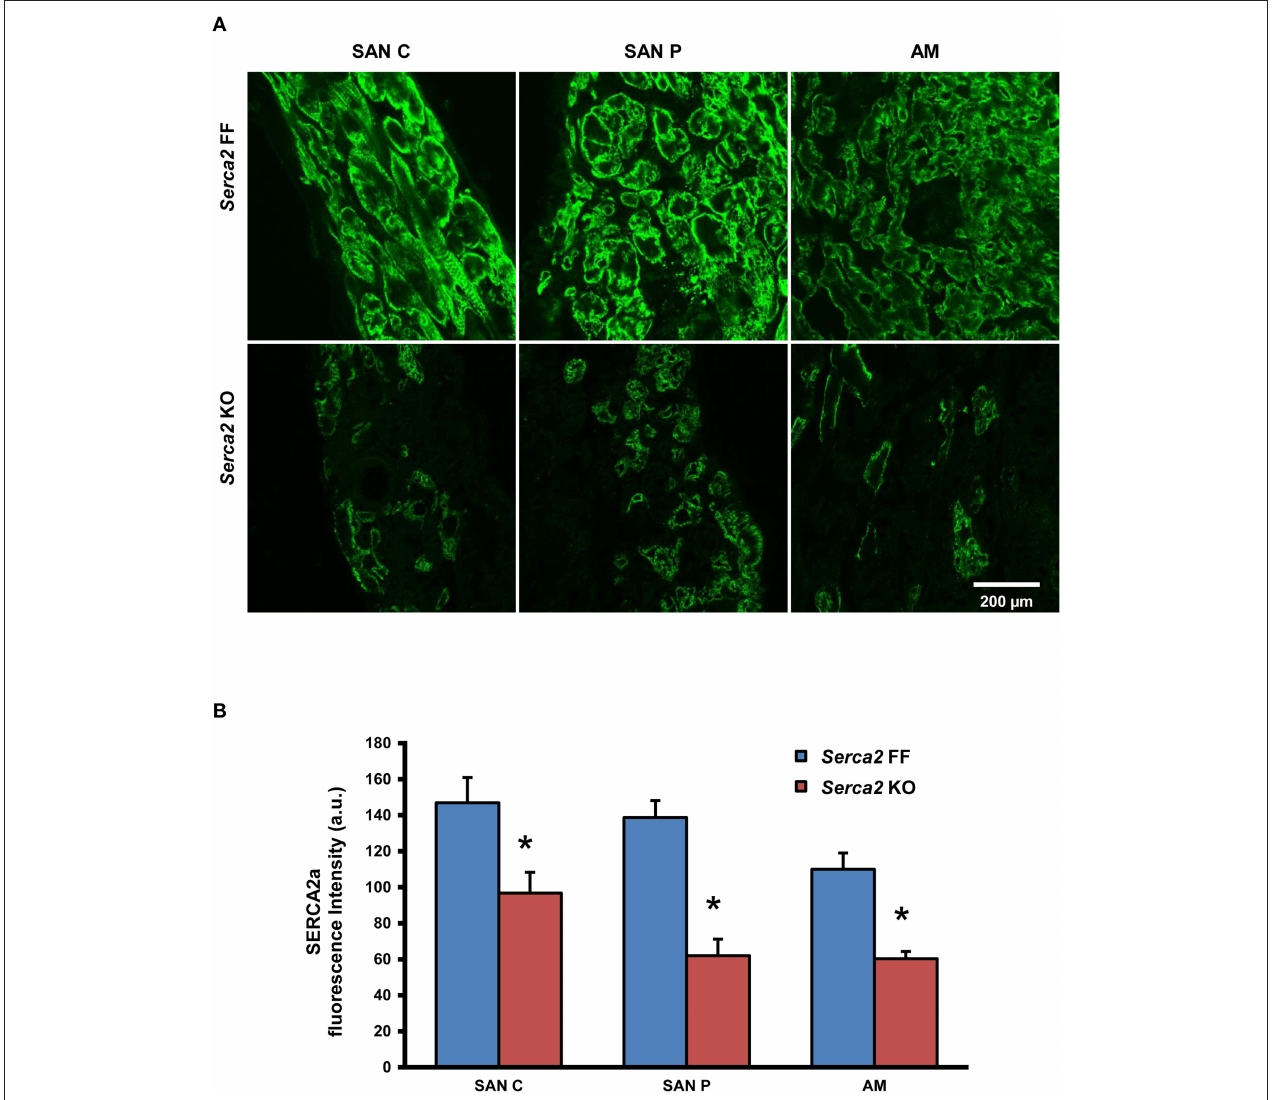
FIGURE 7 | SERCA2a protein expression in the right atrium and sinus node. (A) Representative high magnification images showing SERCA2 labeling (green signal) in the sinus node center (SAN C), sinus node periphery (SAN P) and atrial muscle (AM) of Serca2 FF (top row) and Serca2 KO (bottom row) right atrial tissue sections. (B) SERCA2a fluorescence intensity in the sinus node center (SAN C), sinus node periphery (SAN P) and atrial muscle (AM) of Serca2 FF (blue bars) and Serca2 KO (red bars) tissue sections. * denotes P < 0.05 vs. corresponding Serca2 FF tissue